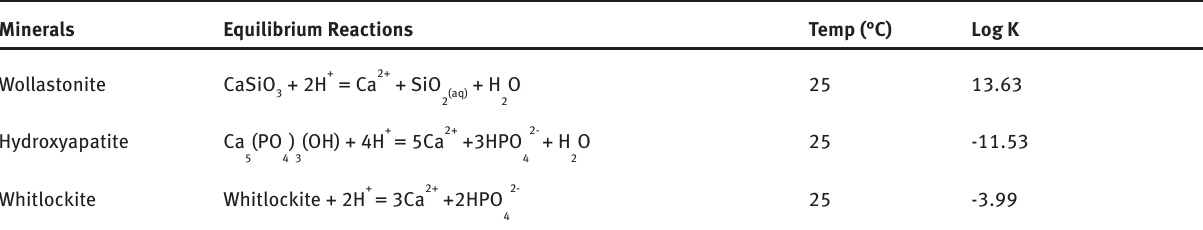
Table 2: Equilibrium reactions for minerals dissolution and precipitation